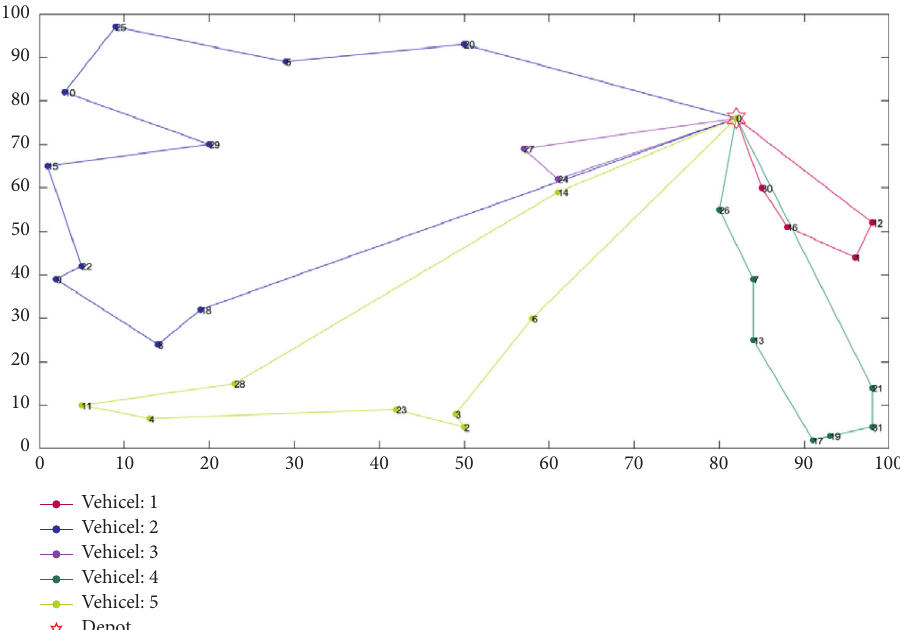
Figure 4: The best route result of the A-n32-k5 by